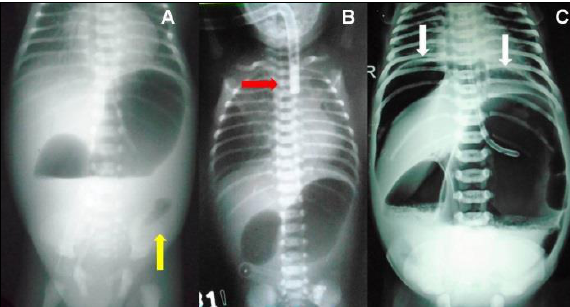
Figure1: Double-bubble appearance with distal gas in a case of perforated duodenal web (A); double-bubble sign with red rubber catheter in upper esophageal pouch in a case of triple atresia (B); Double-bubble sign with pneumoperitoneum in a case of duodenal atresia with gastric perforation (C).